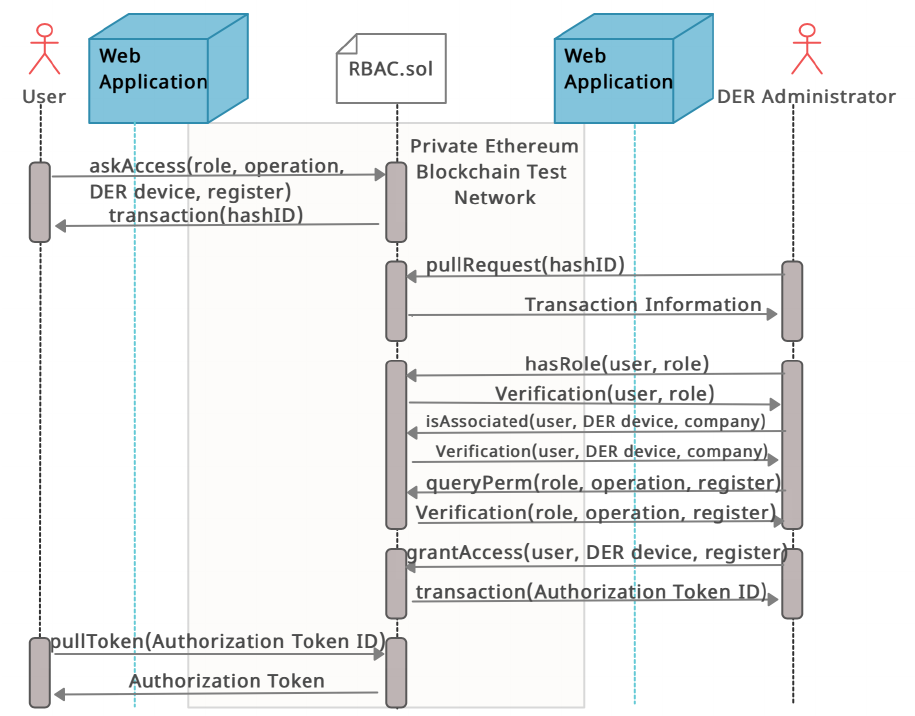
Figure 9. Sequence diagram of user Smart Contract interactions with the RBAC private Ethereum blockchain test